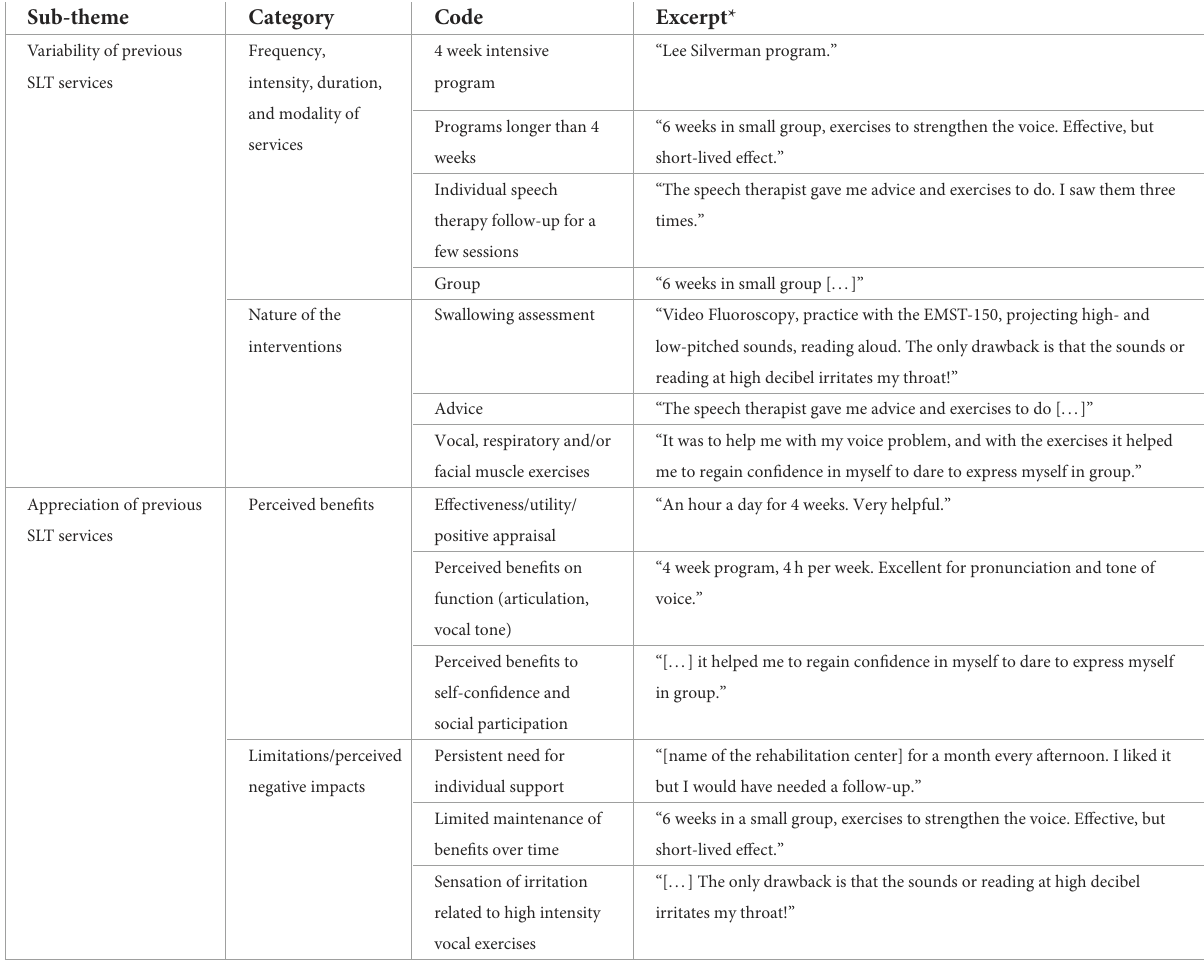
TABLE 2 Previous SLT services are variable and perceived as beneficial but with